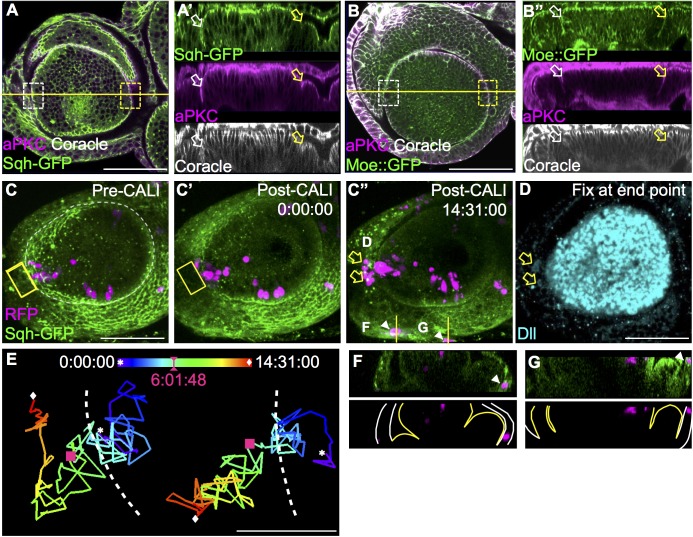
Disruption of myosin activity using CALI permits boundary crossing.(A) Inactivation of actomyosin by Sqh-GFP-mediated CALI. Ex vivo-cultured e-L3 EAD were fixed immediately after CALI treatment (see Materials and Methods). EAD morphology is revealed by Sqh-GFP (green), aPKC (magenta) and Coracle (white) staining. The fold in the control region (non-CALI, white box) and CALI treated region (yellow box) were compared. (A’) In contrast to the control (non-CALI, white arrow), the CALI-treated region (yellow arrow) exhibits a significant reduction in the extent of tissue fold. (B) The actin-binding ERM protein Moe was used as a control for CALI specificity. Expression of Moe::GFP (green) only decorates actin filaments without notable effects. (B’) CALI on Moe::GFP does not affect the A1 fold (compare the non-CALI, white box/arrow, and the CALI-treated region, yellow box/arrow). (C-D) CALI in combination with a clonal tracing experiment. Cells expressing RFP (magenta) were induced upon heat-shock in L2. After 24h, the EAD was dissected, treated with CALI, and monitored for 14-16h. The images were shown in 3D projection. (C-C”) In cultured EAD, inactivation of Sqh-GFP (green) via CALI (yellow boxed region) at the A1 fold (white dashed line) showed that the RFP cells originated from the Dll field across the A1 boundary (arrows in C”, see S2 Movie) and maintained Dll expression (D, blue). (D) Dll expression (blue) after live imaging for 14h. N = 3. (E) Trajectory of the two RFP cells that cross the A1 fold (as cells pointed by yellow arrows in C”). Red squares indicate the RFP positions at post CALI time 6:01:48, with overall trajectory shown in color-coded time map (dashed line: A1 fold). Star and diamond indicate position of RFP cells at T0 and Tfinal post CALI treatment, respectively. (F-G) Cross sections to show that the two RFP clones in C”(marked by white arrowheads) that seemed to have crossed the A1 boundary are actually located in the peripodial epithelium. White and yellow lines outline peripodial and disc proper, respectively. Scale bars: 50μm, except in E: 10μm. Time indicated as hh:mm:ss.